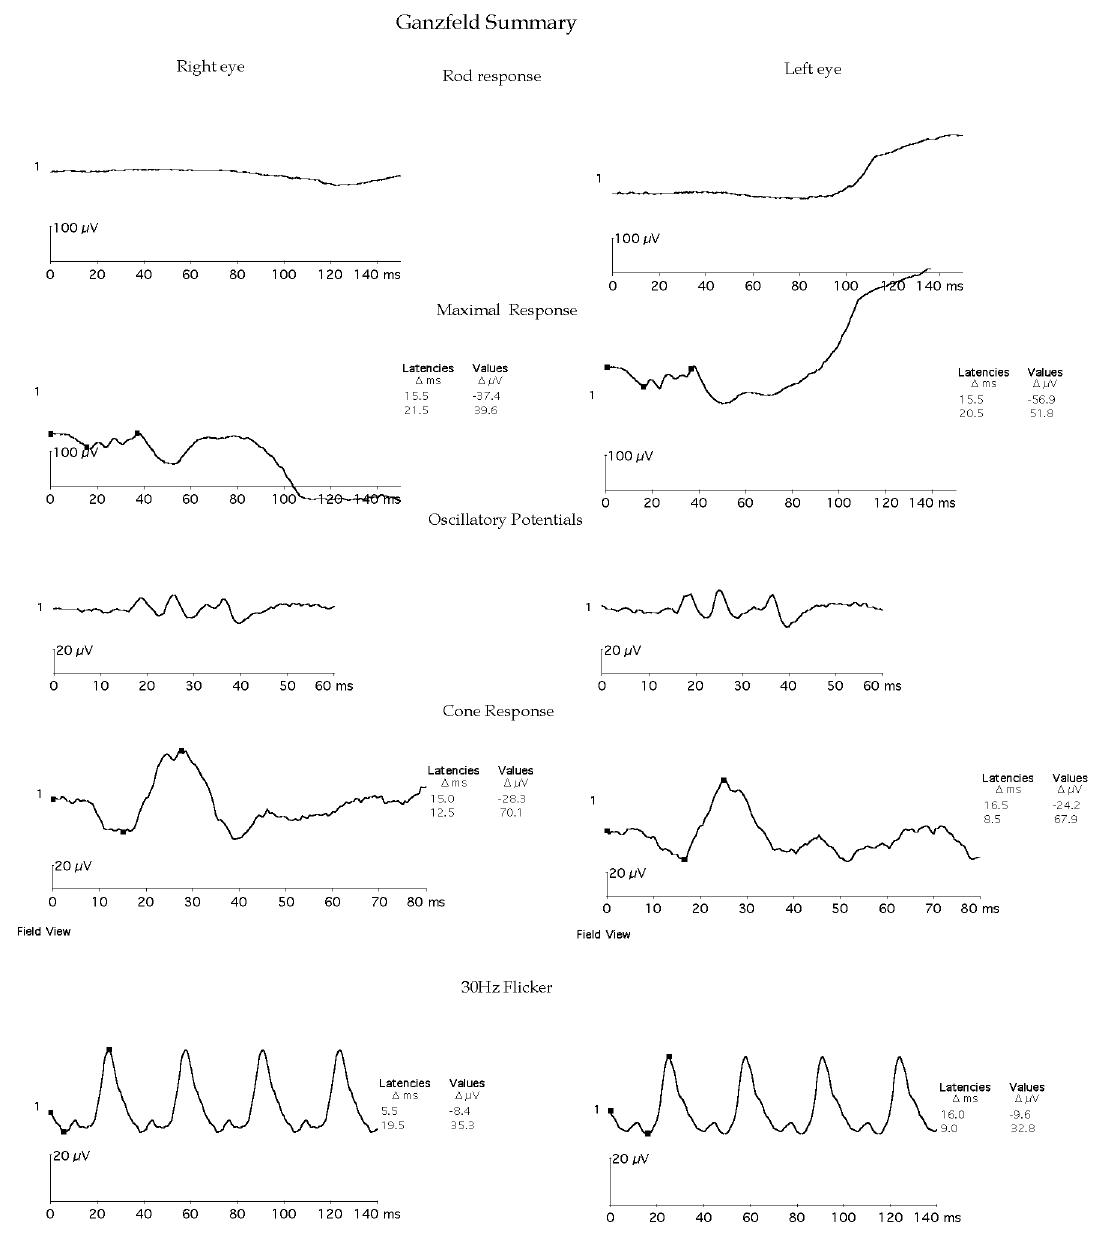
Figure 2: ERG showing the negative waveform morphology with non-recordable single flash rod response, negative-positive combined response, and normal photopic response gene products or the resultant mutant proteins are inac-